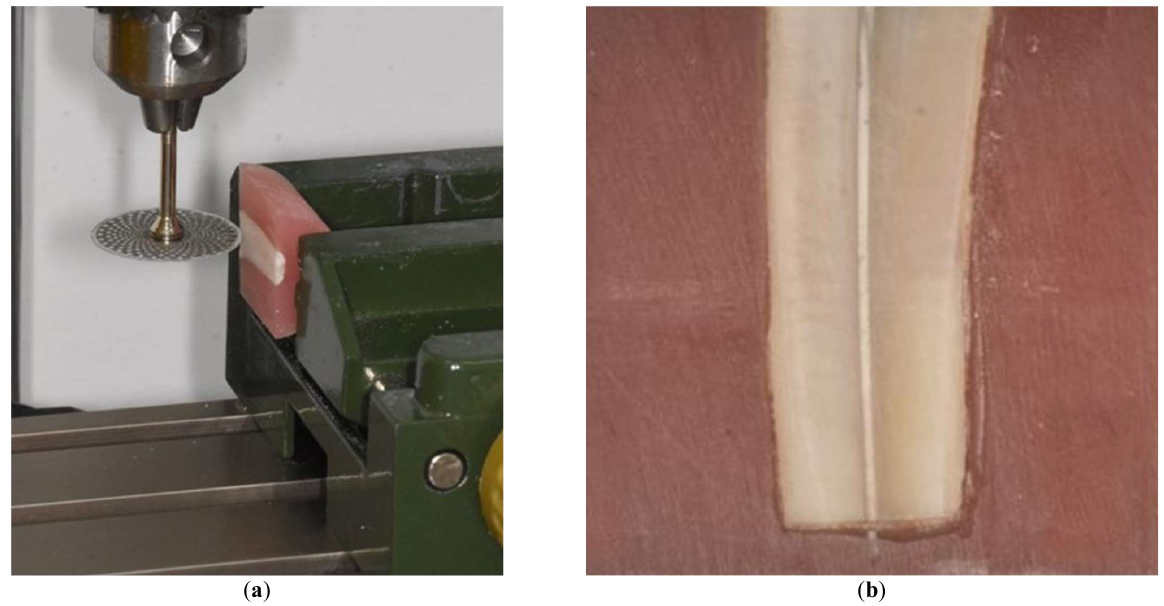
Figure 3. Creation of artificial canal on a precision milling machine ( a ) and aspect of the artificial canal ( b